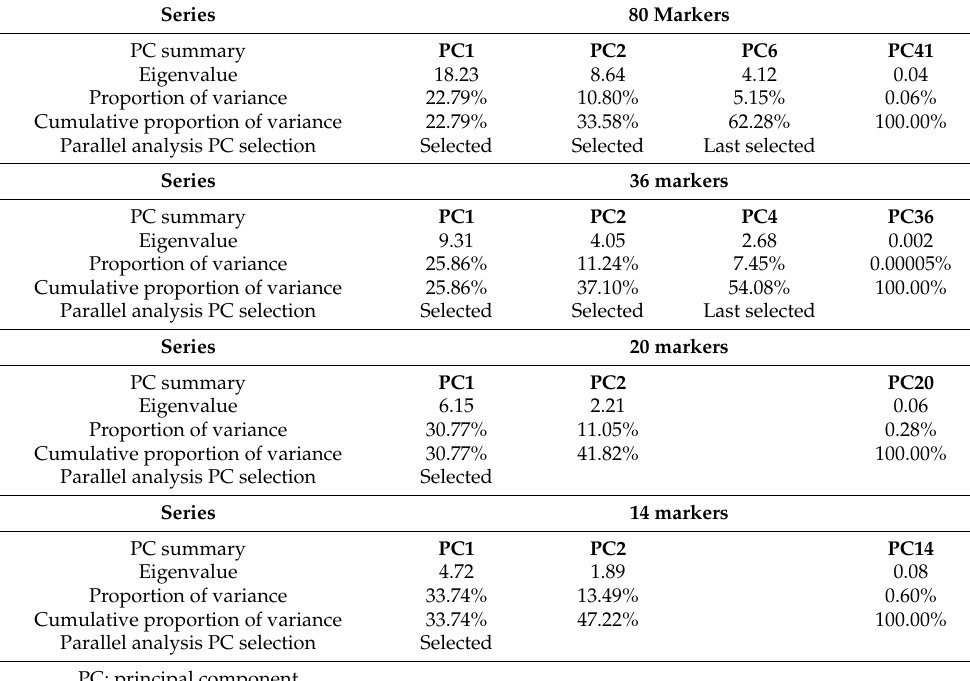
Figure 5. PCA of the 80 protein markers. ( A ) The PC score plots illustrate the relationship between the NEC (N1 to N7 group A, B, C: in red) and non-NEC control (C1 to C7 group A, B, C: in blue) samples when the dimensionality of the dataset is reduced to its two principal components (PC1: x-axis; PC2: y-axis). ( B ) Protein loadings show how each protein marker (increased in NEC: from 1 to 40; decreased from 41 to 80; see Supplementary Table S1 for corresponding protein name) is correlated with the two principal components of the PC score plots. Table 1. PCA information on series’ principal